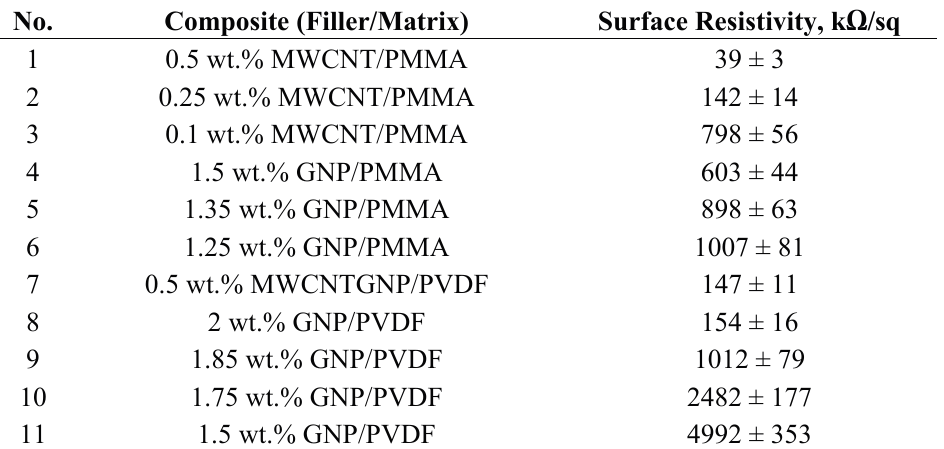
Table 1. Results of the surface resistivity